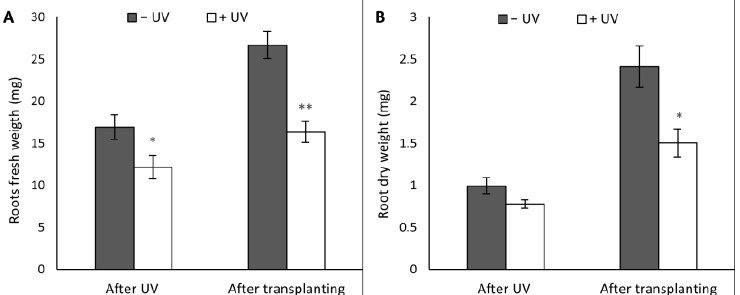
Figure 9. Parameters measured were root fresh weight (mg) ( A ) and root dry weight (mg) ( B ). Before the UV, the mean of the root fresh weight was 8.00 mg while the mean of the root dry weight was 0.54 mg. Asterisks indicate a significant difference between the UV treatments with p < 0.05 (*) or p ≤ 0.001 (**).